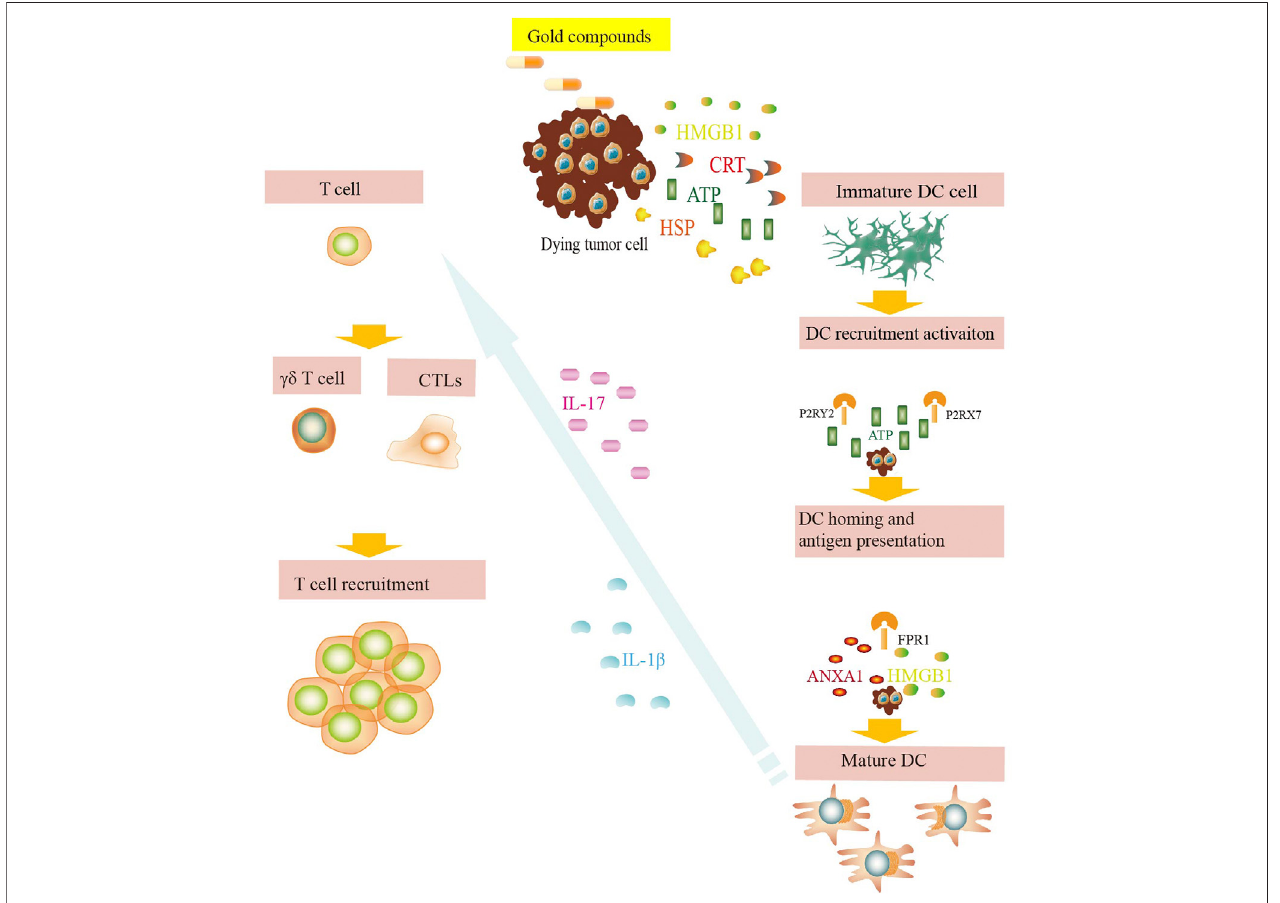
FIGURE 4 | DAMP signals during exposureto gold compounds. Dying tumor cells expose CRT on their surface and release ATP, HMGB1, HSPs, etc. and bind to theirrespectivesurfacereceptorsonmyeloidorlymphoidcells.Thesedangersignalsfavortheuptakeofdebrisanddeadcellsbyantigenpresentingcells,includingDCs. The dying tumor cells induce release ofIL-17 and IL-1 β , which favor the recruitment ofTcells. Thesephenomena eventually leadtothe priming ofan anticancer immune response.